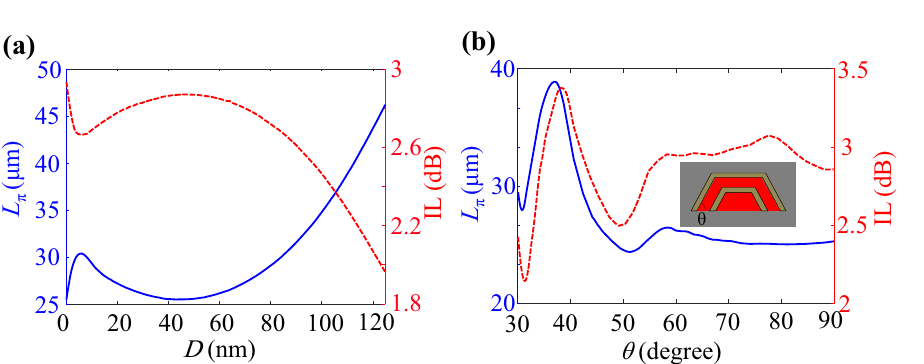
( n eff ) and ( n eff ) of the proposed waveguide at N 0 Figure 5. ( a ) ℜ ℑ applied voltage. The guided mode electric field profiles in ( b ) pull, ( c ) on and ( d ) push states on the color scales 1 to 1 V/m. of −